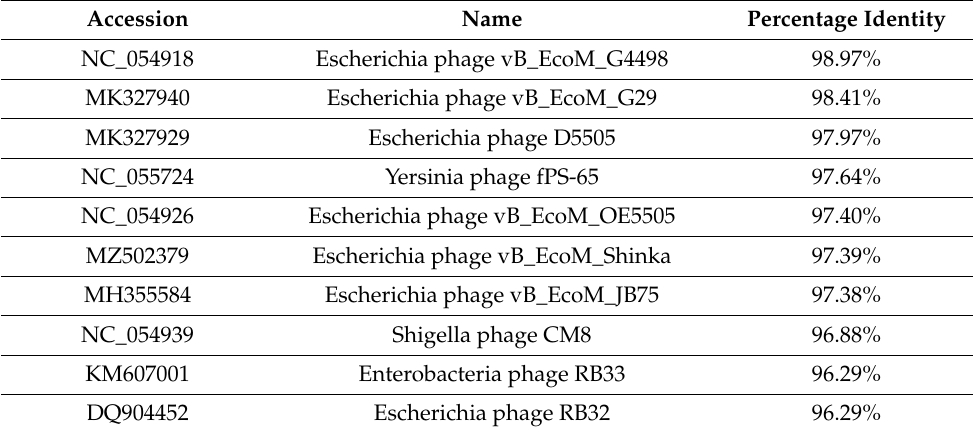
Table 5. BLAST Analysis. The top ten BLAST hits of APTC-EC-2A in the database.